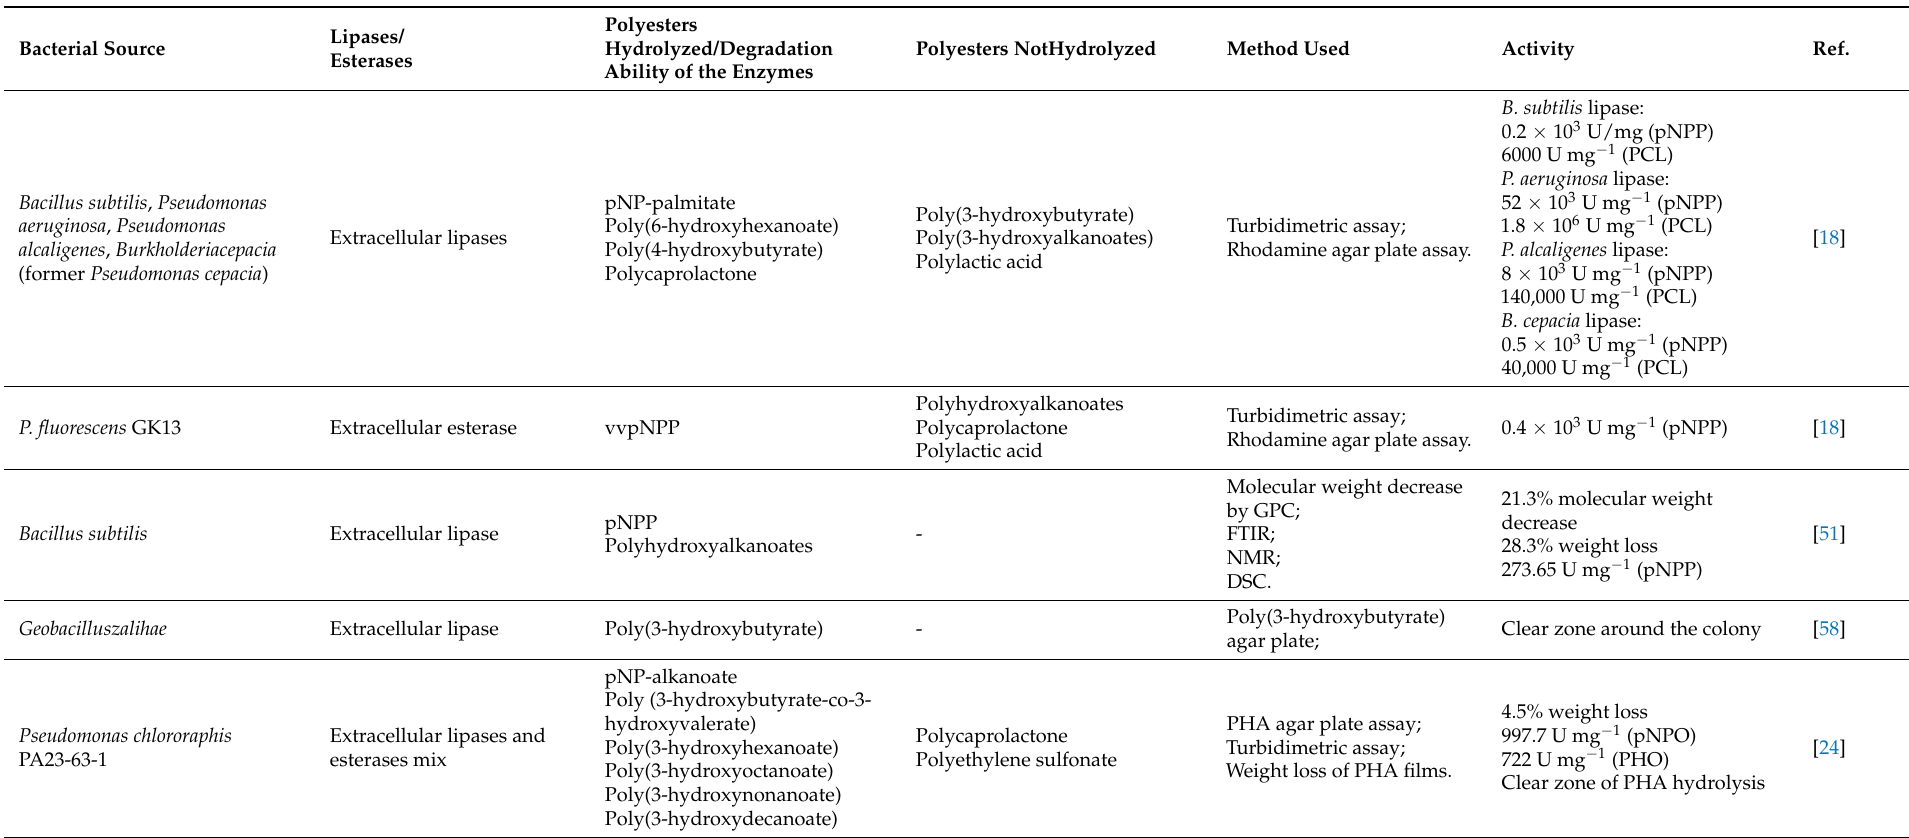
Table 7. Degradation of polyesters by bacterial lipases and PHA